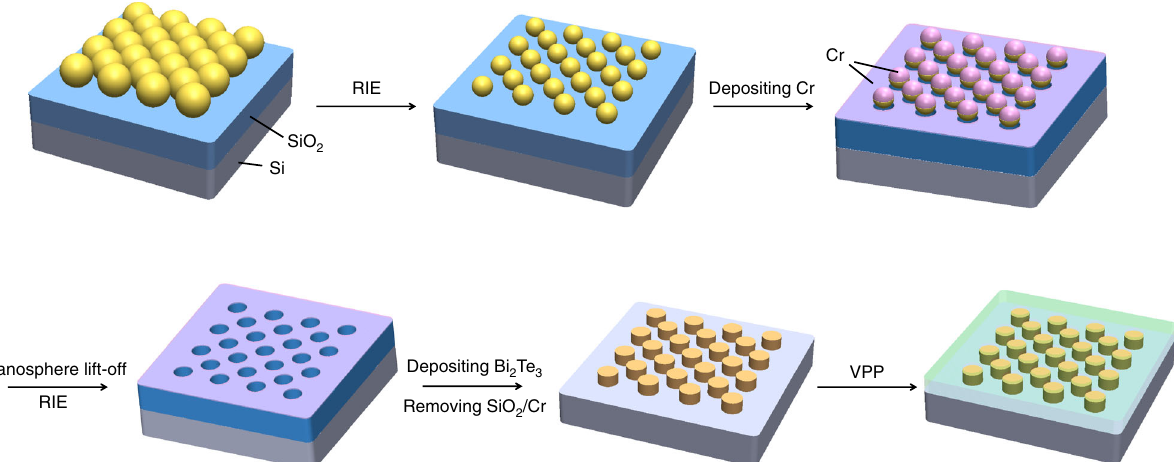
Fig. 1 Scheme of controllable design for organic/inorganic hybrid fi lm. Fabrication procedure for poly(3,4-ethylenedioxythiophene) (PEDOT)/Bi 2 Te 3 hybrid fi lms, including nanosphere lithography and reactive ion etching (RIE) for nanohole arrays template, fi lling Bi 2 Te 3 into the template by thermal evaporation, removing the template, and compositing Bi 2 Te 3 nanoparticle arrays with PEDOT by vapor-phase polymerization (VPP) process. The geometrical parameters of the resultant nanostructure can be tuned by the diameter of polystyrene (PS) nanospheres and the etching time for PS